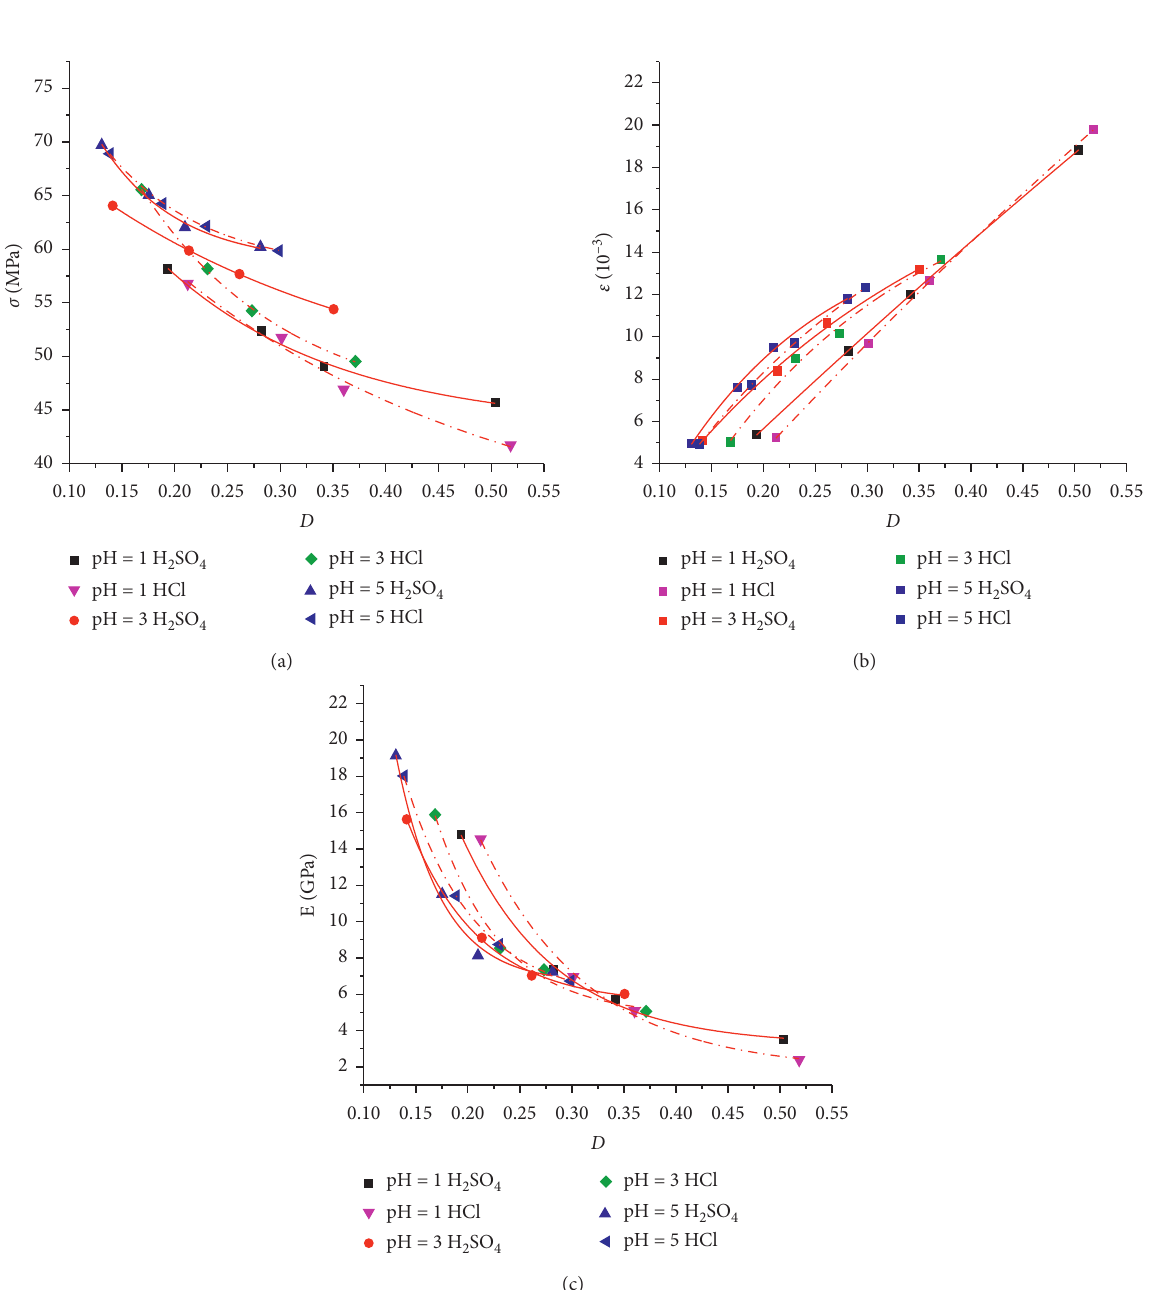
Figure 12: Relationship between the damage variables of the sandstone samples and (a) peak stress, (b) peak strain, and (c) elastic